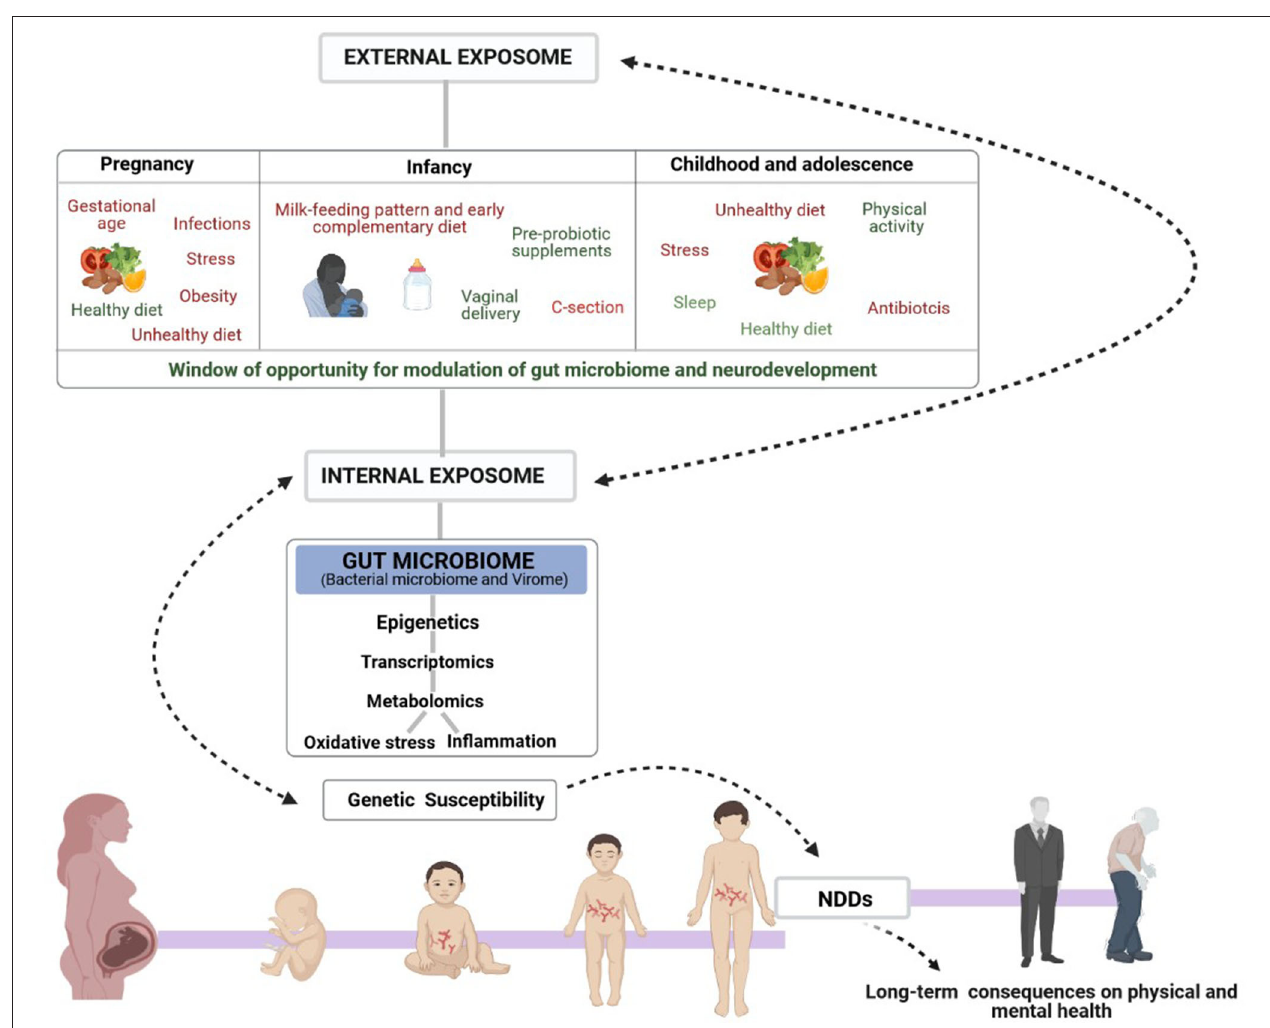
FIGURE 1 | Schematic representation of the complex Exposome-Genome interplay in human neurological development. The figure also shows the early window of opportunity for gut-microbiome and neurodevelopmental modulation to influence mental health, mainly through dietary interventions. Early non-genetic risk and protective factors of the external exposome (prenatal, infancy, childhood and adolescence lifestyle factors) interact with the internal exposome (biological factors such as gut microbiota, metabolism, inflammation, and oxidative stress) controlling the onset of the most common NDDs in genetically susceptible individuals and consequent physical and mental health in adult